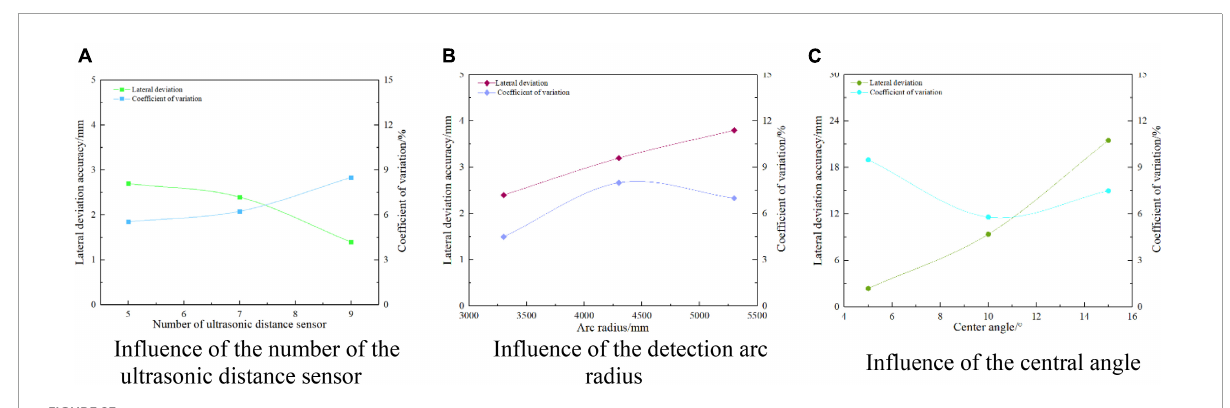
FIGURE22 A single factor affects the accuracy of heading deviation detection.